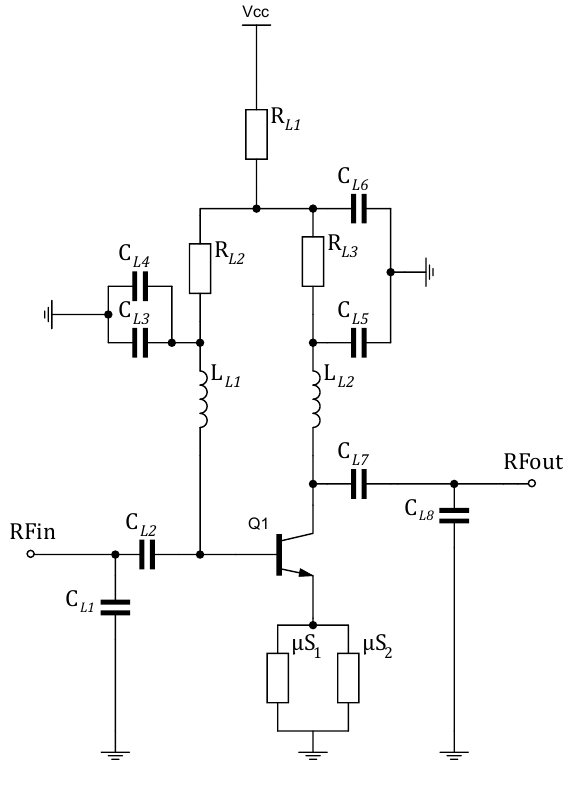
Figure 5. Schematic of